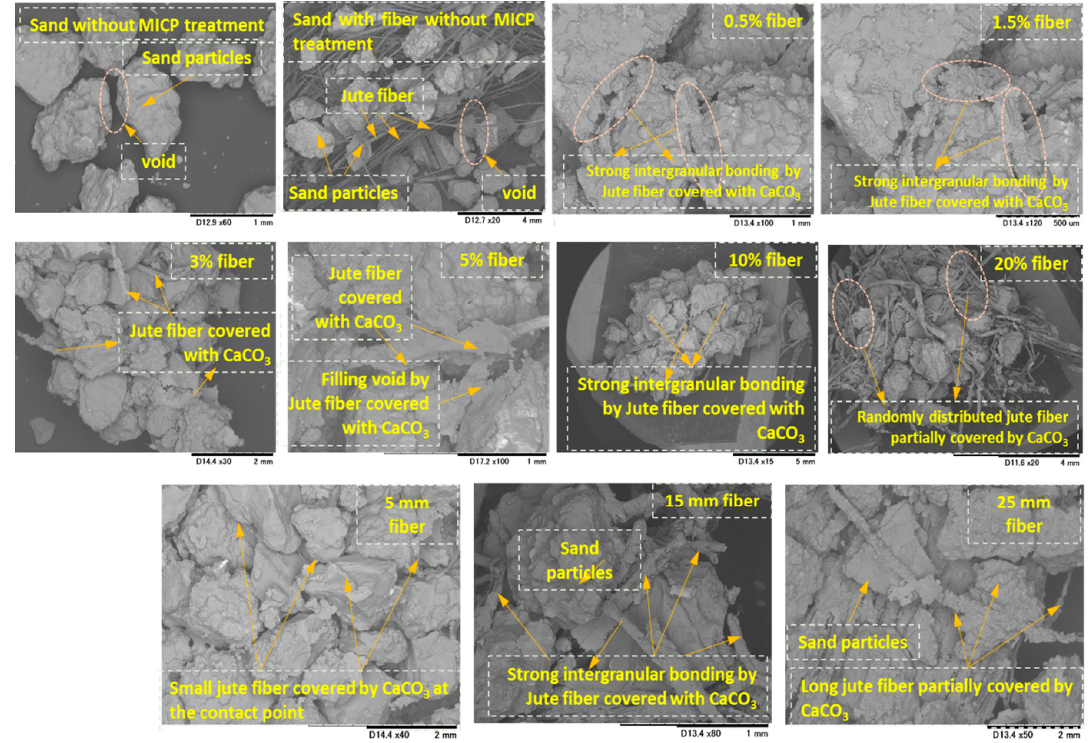
Figure 17. SEM images of MICP-treated biocemented samples with the addition of jute fibers (considering different lengths and contents) and distribution of CaCO 3 within the sand matrix.